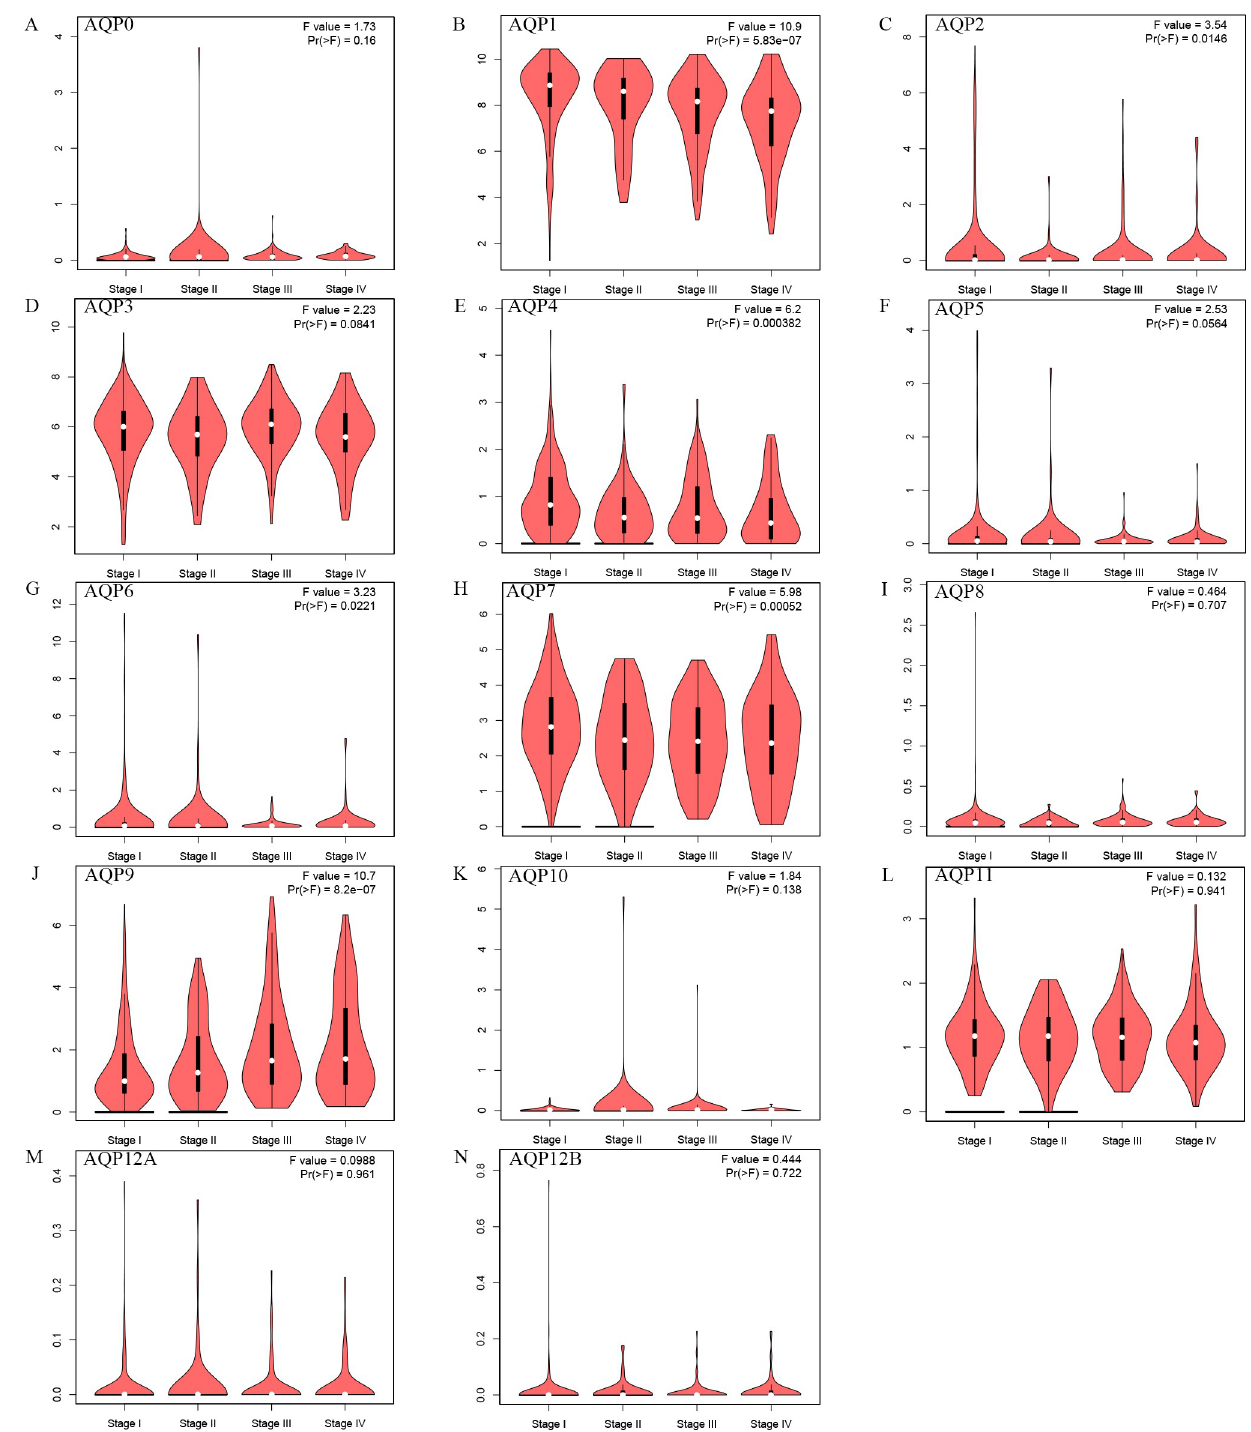
Fig 4. Relationship between mRNA expression of AQPs and individual cancer stages of ccRCC patients (GEPIA). The figure was visualized using violin plots. mRNA expression levels of AQP1/2/4/6/7/9 were remarkably correlated with patients’ individual cancer stages, while the expression across stages did not significantly differ for AQP0/3/5/8/10/11/12A/12B. The method for differential expression gene analysis was one-way ANOVA, using the pathological stage as the variable for calculating differential expression. The F-value was the test statistic from the F-test. The Pr ( > F) was the p-value of the F-test and the p-value < 0.05 was